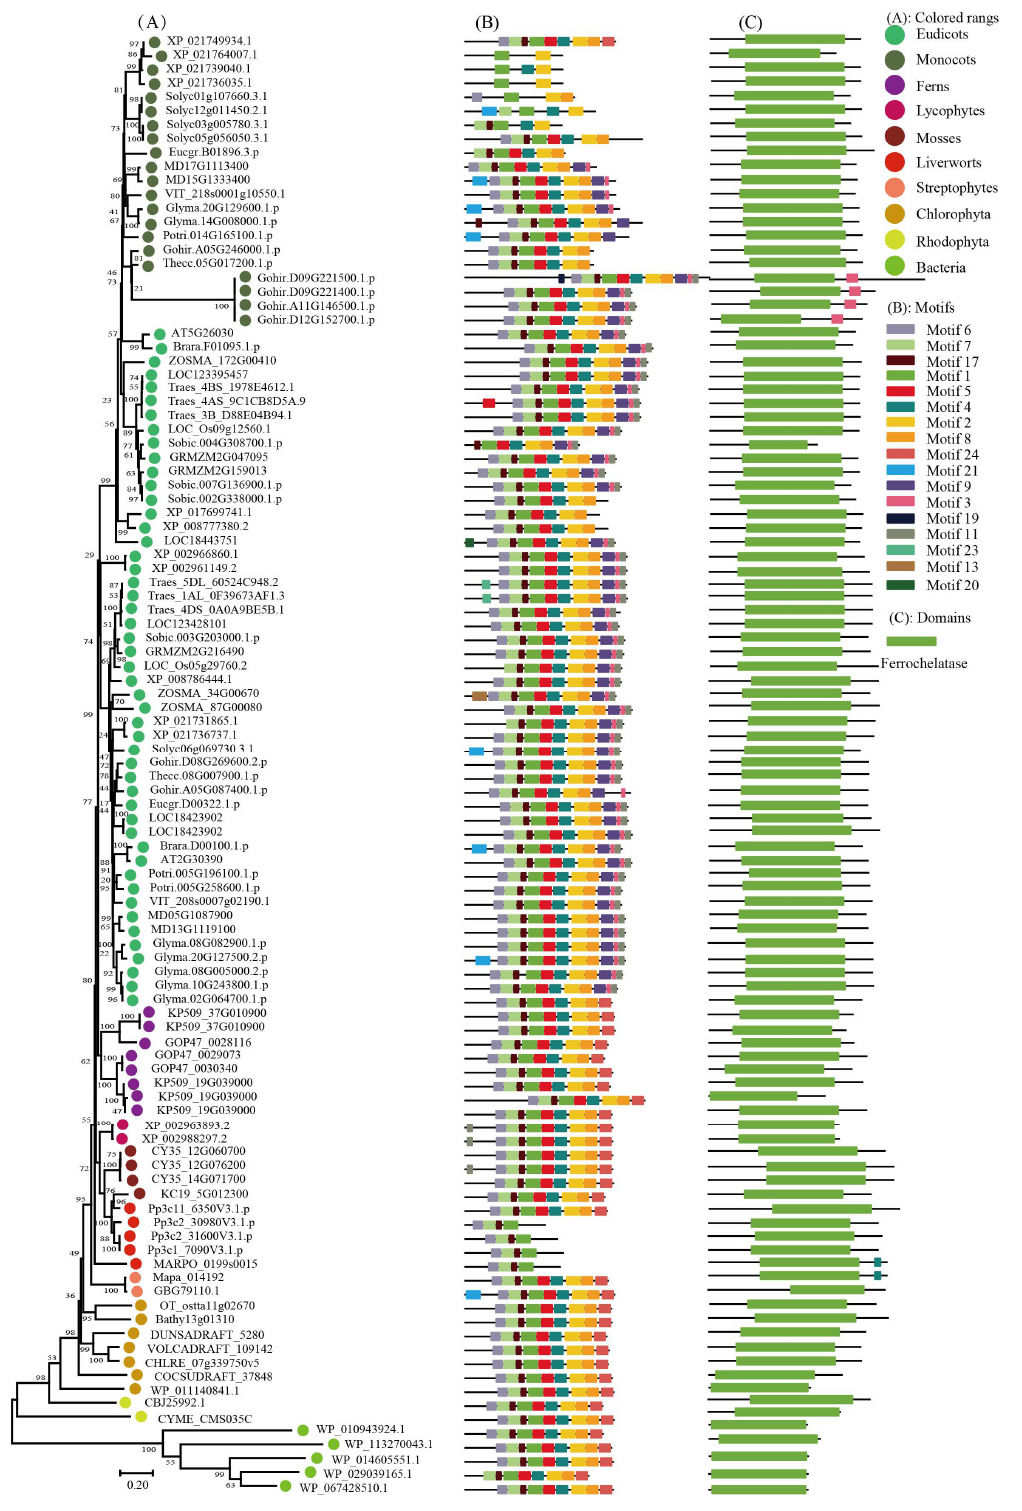
Figure 7. Phylogenetic evolutionary tree, protein motifs, and domains of the FCII subfamily members: ( A ) Unrooted phylogenetic tree of the FCII subfamily; ( B ) motifs of the FCII proteins. The different colors indicate seventeen motifs (left panel); ( C ) protein domains of the FCII genes.